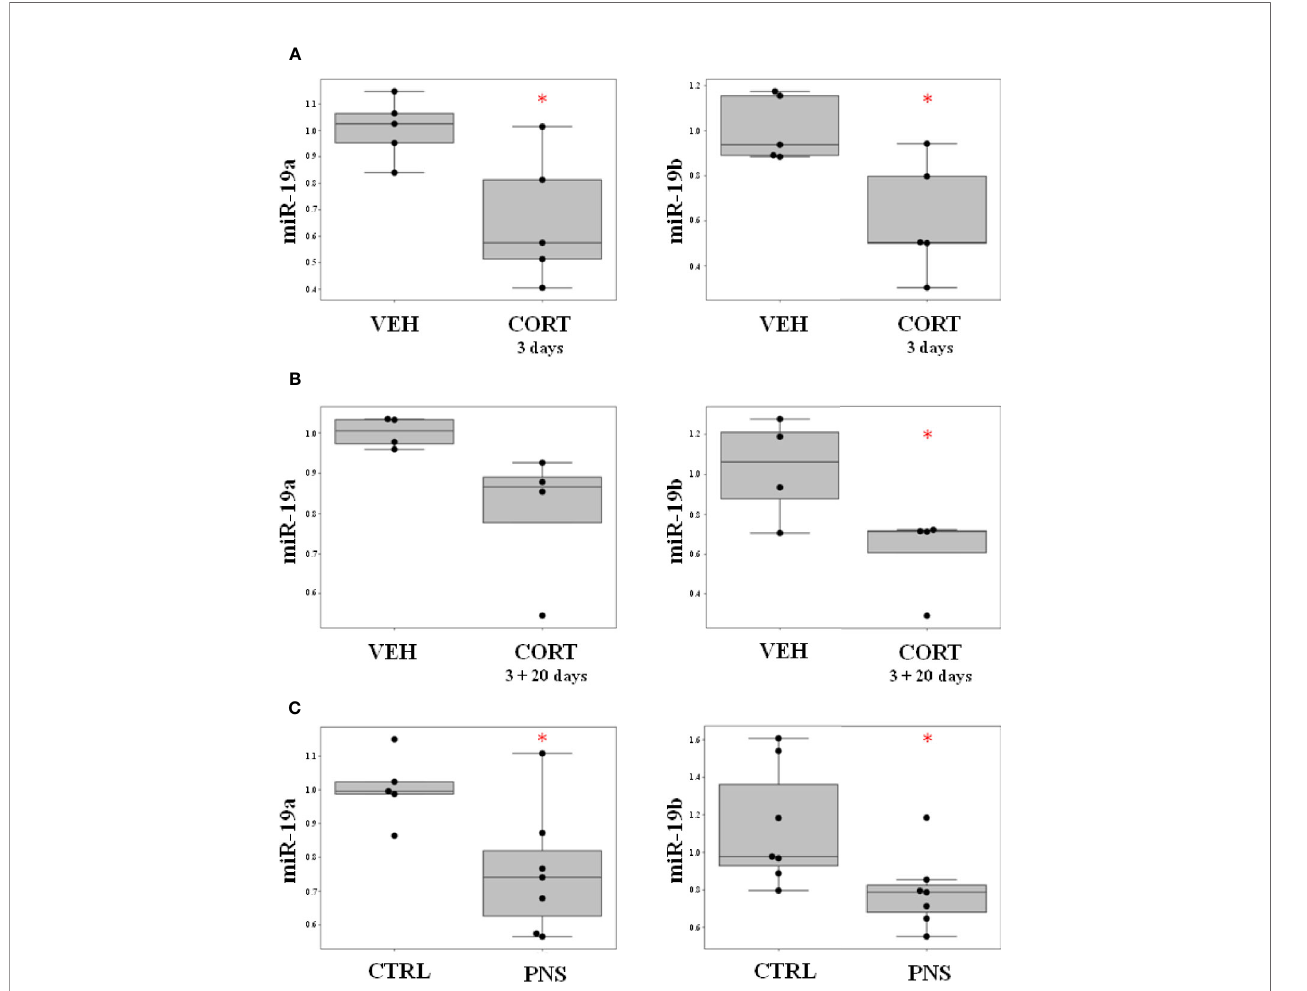
FIGURE 1 | (A) Effect of ELS on the modulation of miR-19a and miR-19b in HPC0A07/03C cells treated with cortisol during 3 days of proliferation as compared to cells treated with vehicle. (B) Effect of ELS on the modulation of miR-19a and miR-19b in HPC0A07/03C cells treated with cortisol during 3 days of proliferation and differentiated into mature neurons for 20 days as compared to cells that received vehicle. (C) Effect of PNS on the modulation of miR-19a and miR-19b in adult PNS rats (PND 62) as compared to control animals. Data are shown using boxplot, *p-value <